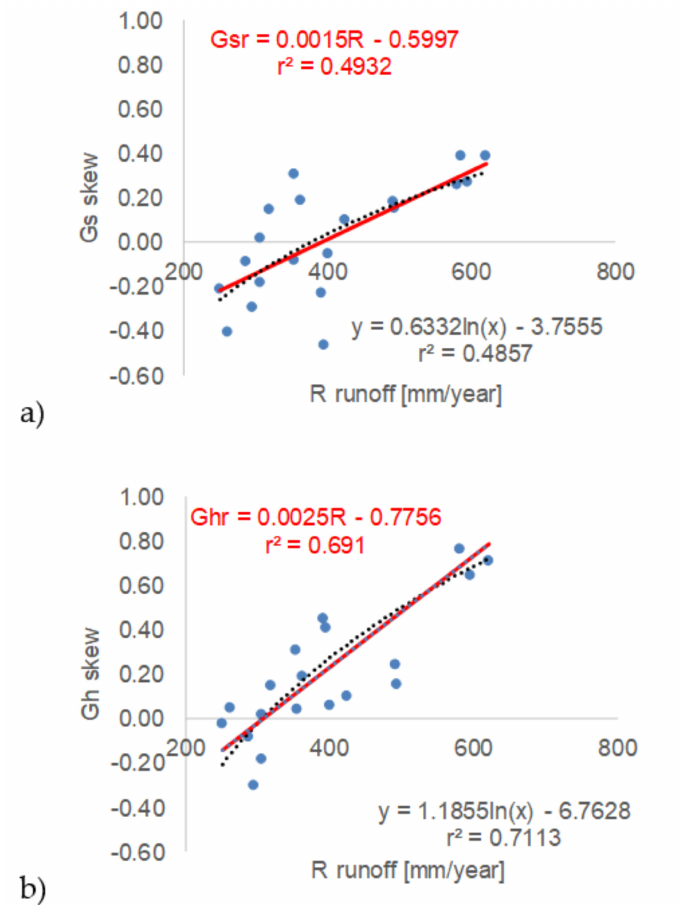
Figure 8. Dependence of the skew coefficient G on the runoff depth at Danube River gauges: ( a ) Gs: without historical floods; ( b ) Gh: with historical floods in some gauging